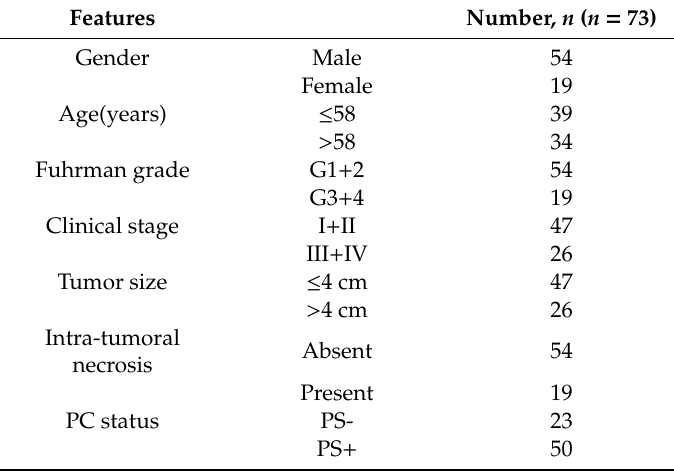
PC: pseudo-capsule. PC: